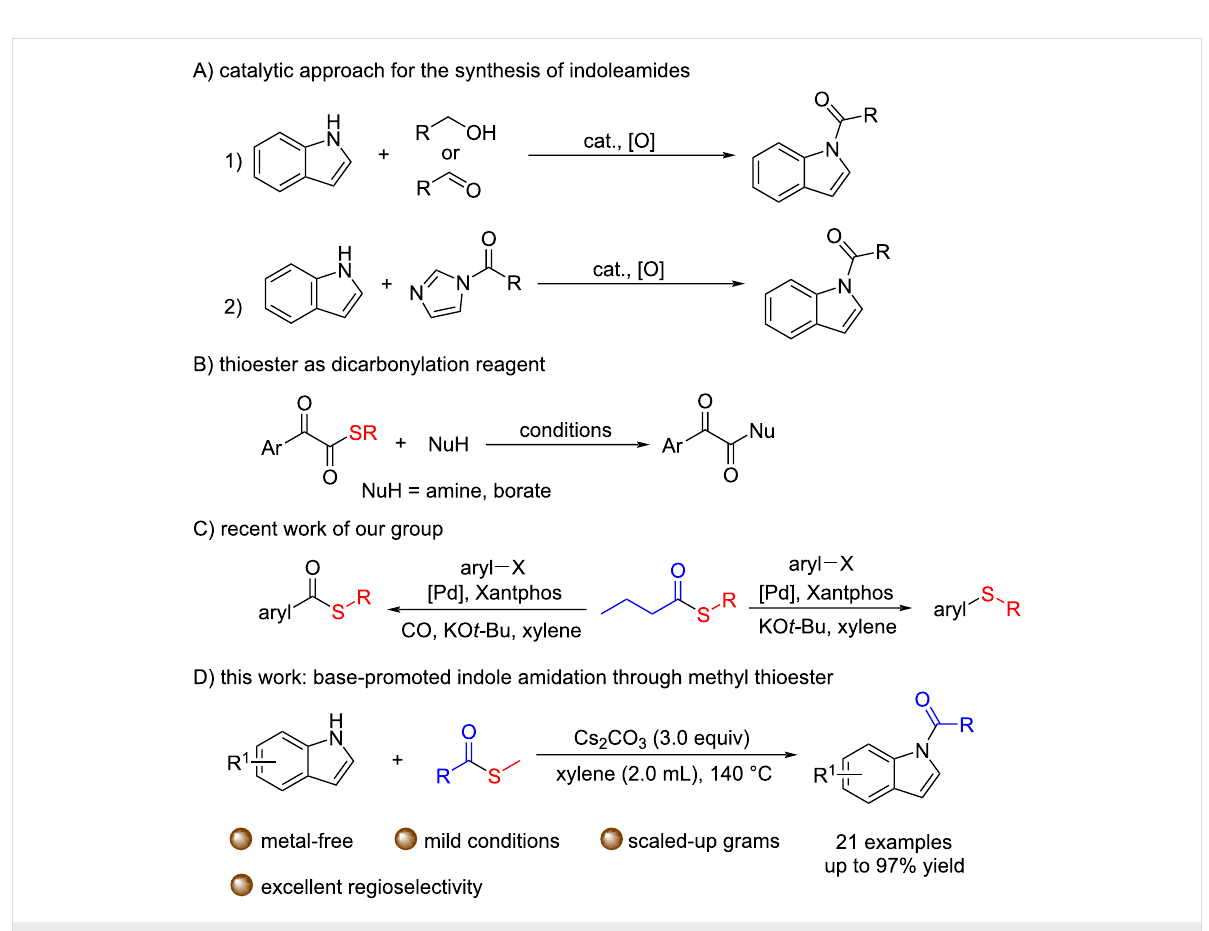
Figure 1: Representative pharmaceuticals containing N -acylindole